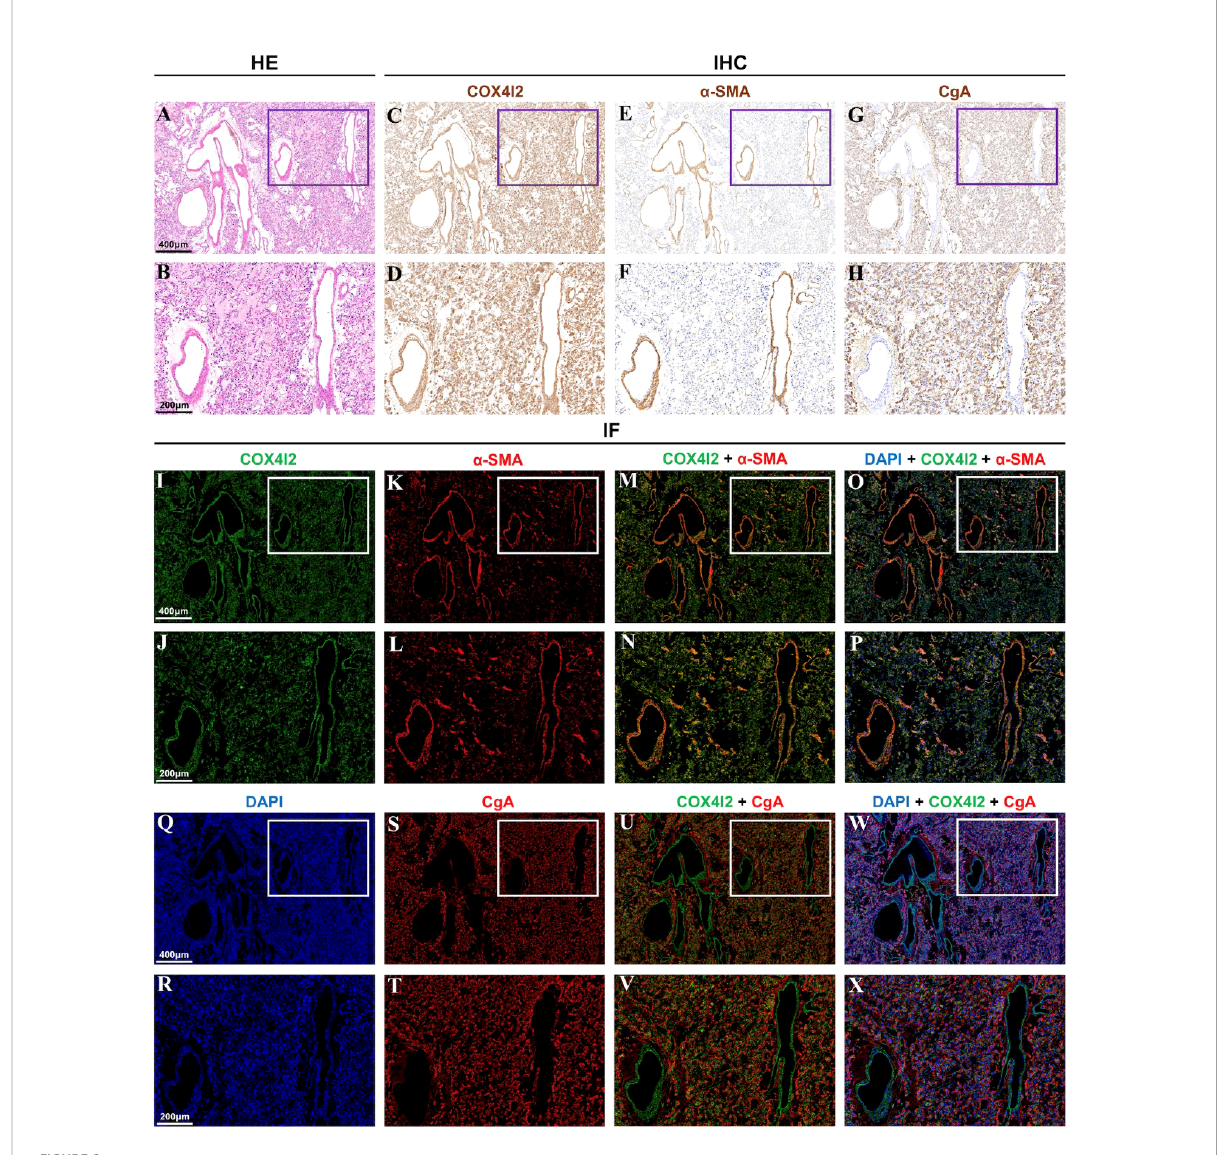
FIGURE 2 Different staining analysis of the same vascular area in pheochromocytoma tissue. (A, B) Hematoxylin and eosin staining showed the vascular lumen area. (C – H) Immunostaining of COX4I2, a -SMA and CgA was performed in the same area. (I – X) . Immuno fl uorescence staining of COX4I2, a -SMA, DAPI and CgA was performed in the same